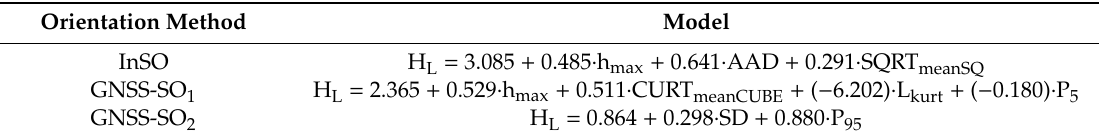
Table 5. Plot-level H L models (equations with parameters and included predictors) developed using multivariate linear regression (backward stepwise) for each point cloud (orientation